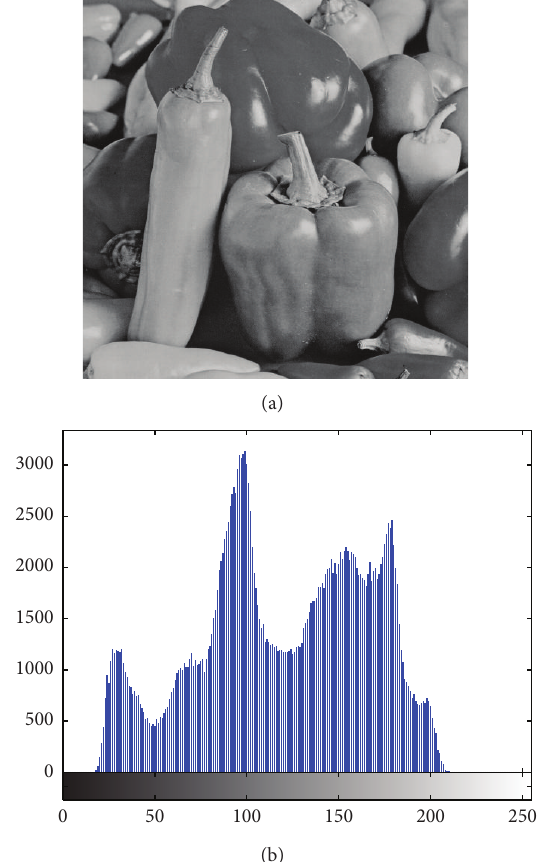
Figure 5: (a) Plain image and (b) its histogram.